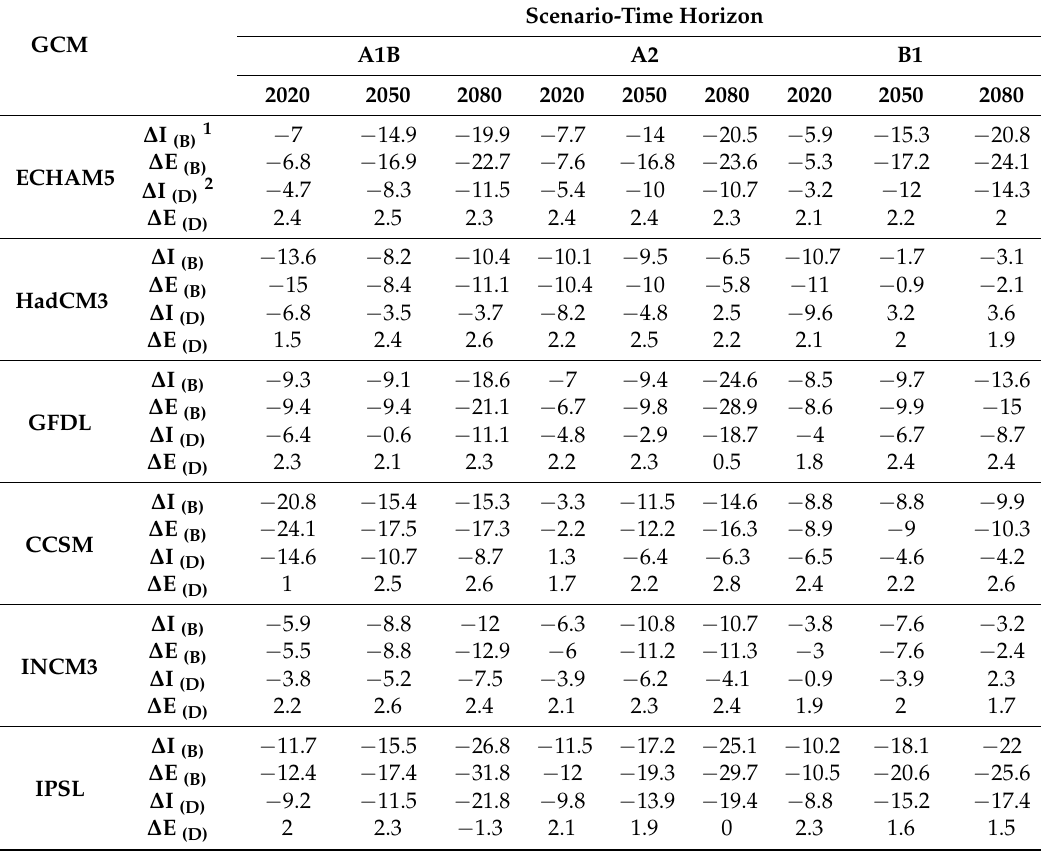
Table 5. The percentage of variation of the inflows and the hydropower generation of the Bakhtiari and Dez reservoirs under climate change conditions projected by the six GCMs and three SRES scenarios for the 2020s, 2050s, and 2080s time horizons compared to the base period.